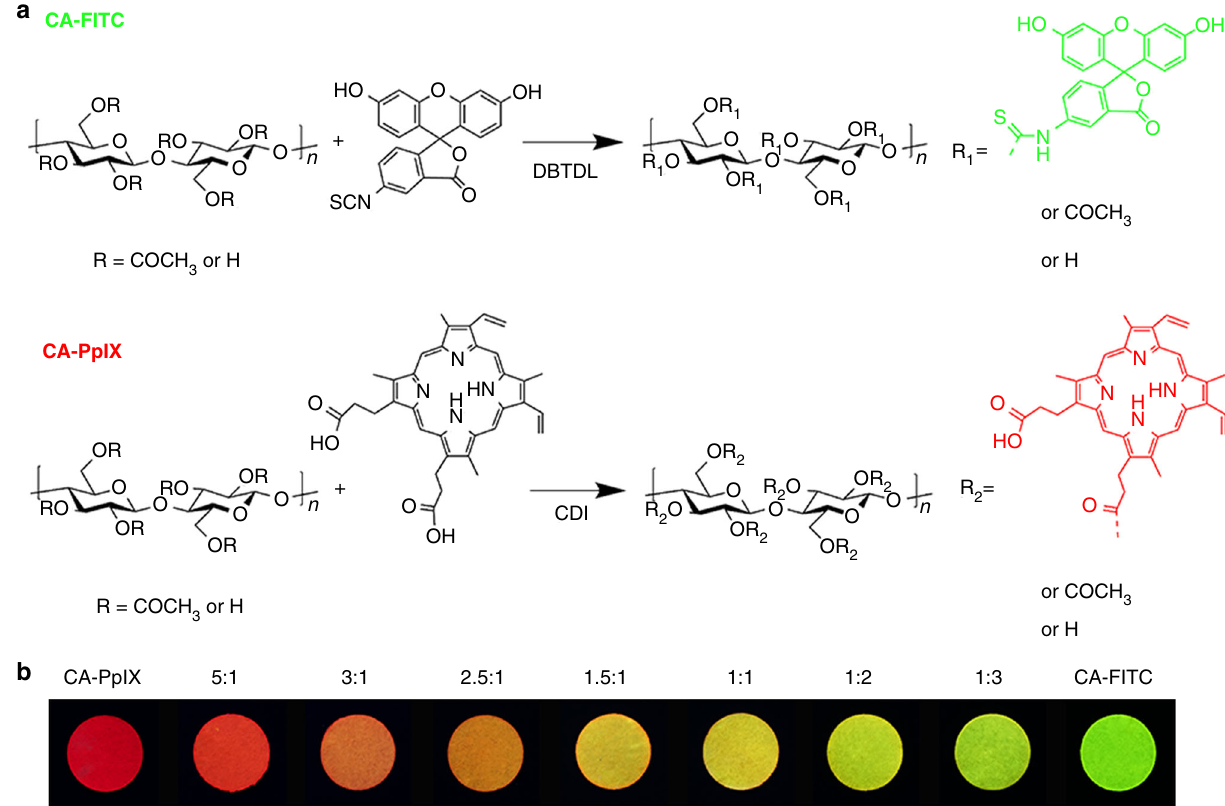
Fig. 1 Preparation of cellulose-based ratiometric fl uorescent materials. a Synthetic routes of CA-FITC and CA-PpIX. b Cellulose-based dual-emission solid fl uorescent materials with different mix ratio of CA-PpIX to CA-FITC (w/w), namely 1:0, 5:1, 3:1, 2.5:1, 1.5:1, 1:1, 1:2, 1:3, 0:1, respectively, under 365 nm UV